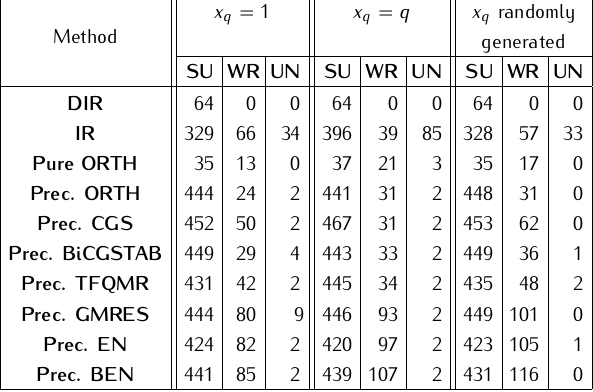
Table 11. As Table 7 (i.e. ACCUR = 10 − 4 ), but relative residual norms, introduced by (8) , are used in the stopping